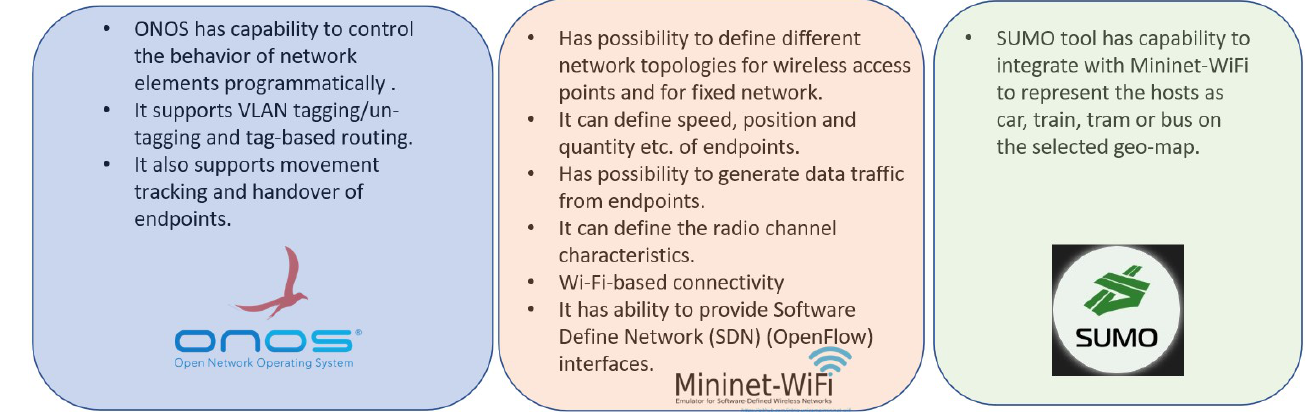
Figure 1. Selected